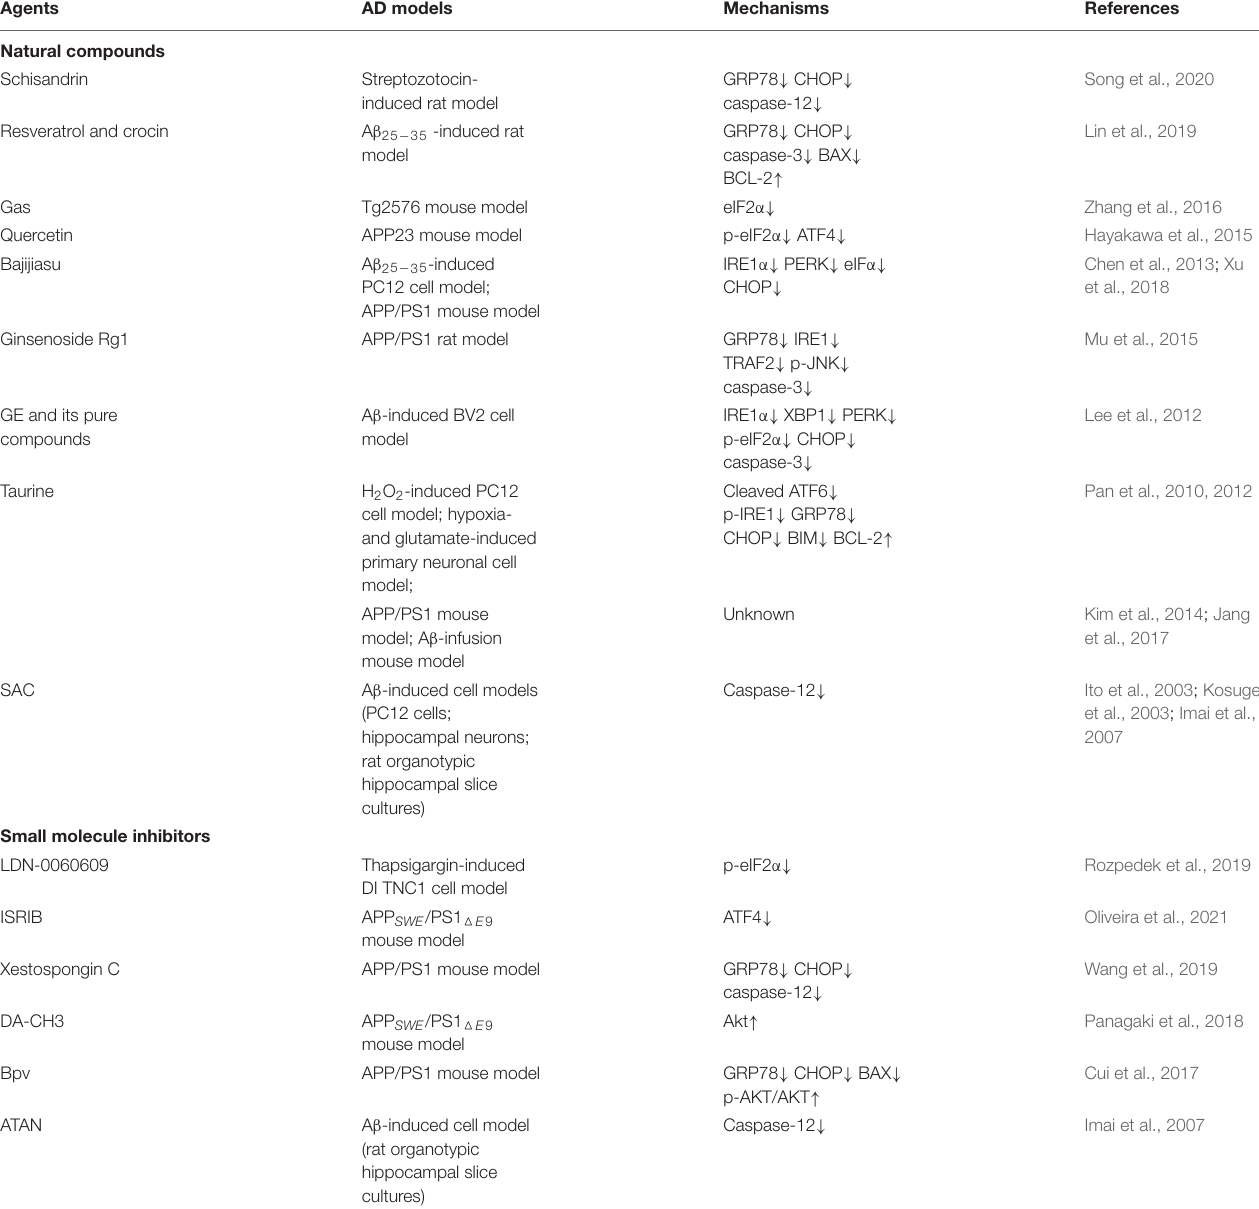
TABLE 1 | Natural compounds and small molecule inhibitors targeting ER stress and ER stress-mediated apoptosis in treating Alzheimer’s